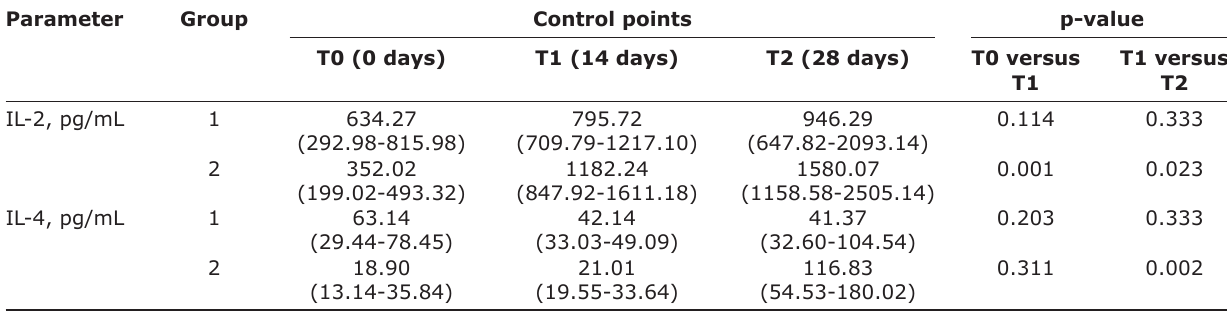
Table-5: Immunoassay analysis of cytokines (Me [P25-P75]). Parameter